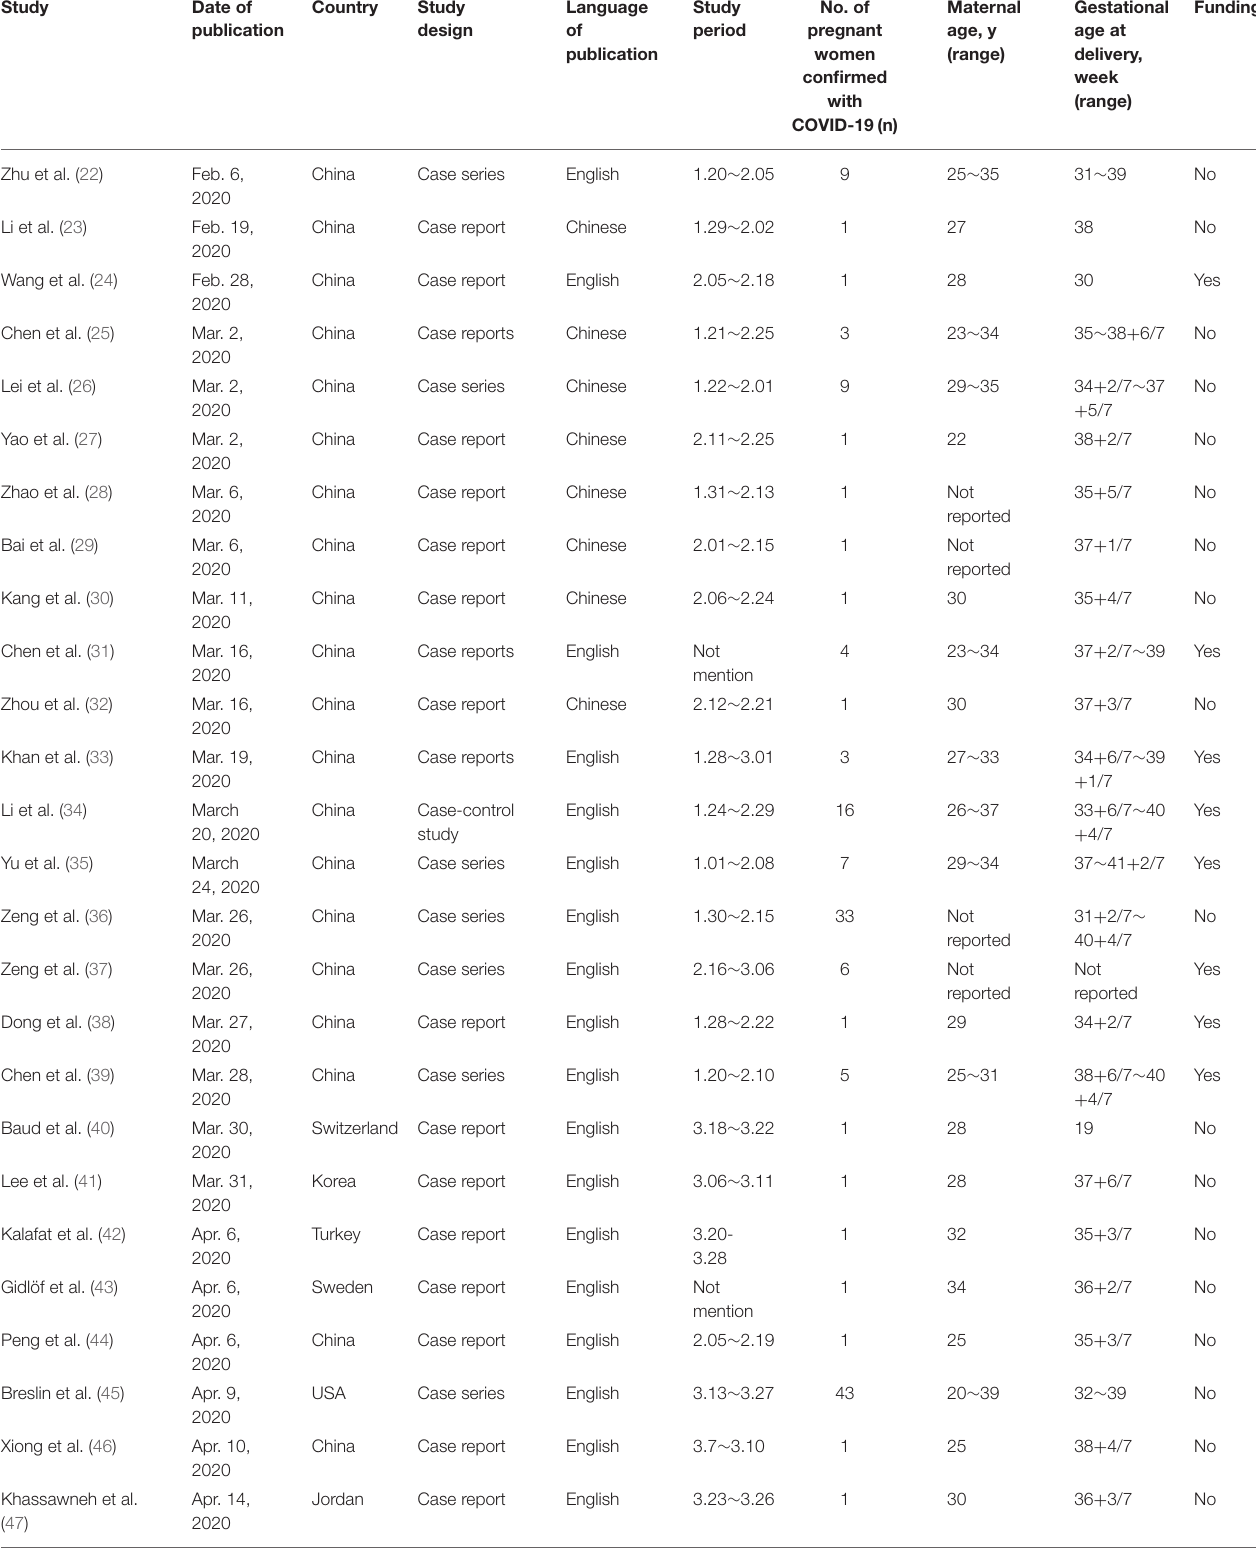
TABLE 1 | Characteristics of the included